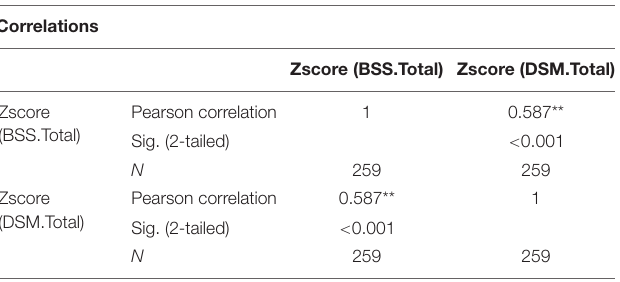
TABLE 2 | Summary of correlations between Zscore BSS.Total and Zscore DSM.Total. Correlations